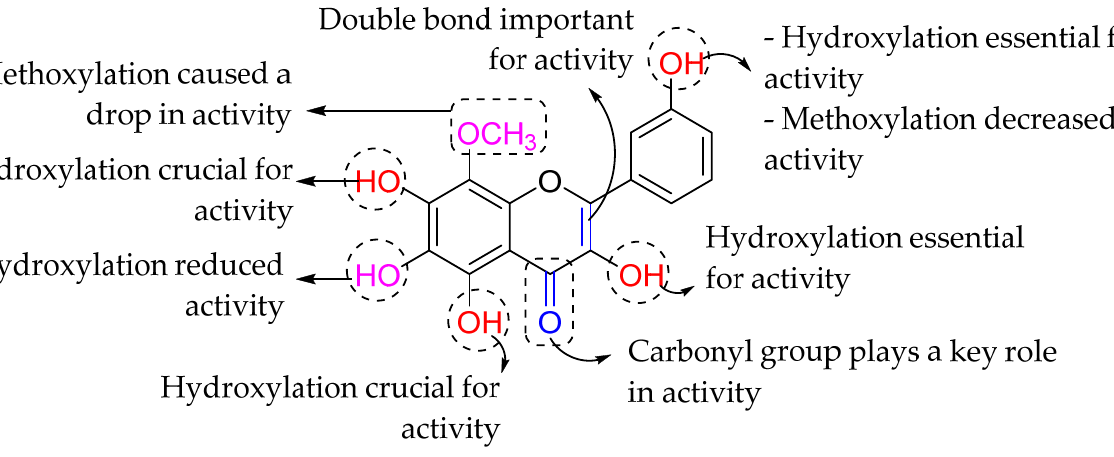
Figure 34. Summary from the 3D-QSAR and docking studies [104].